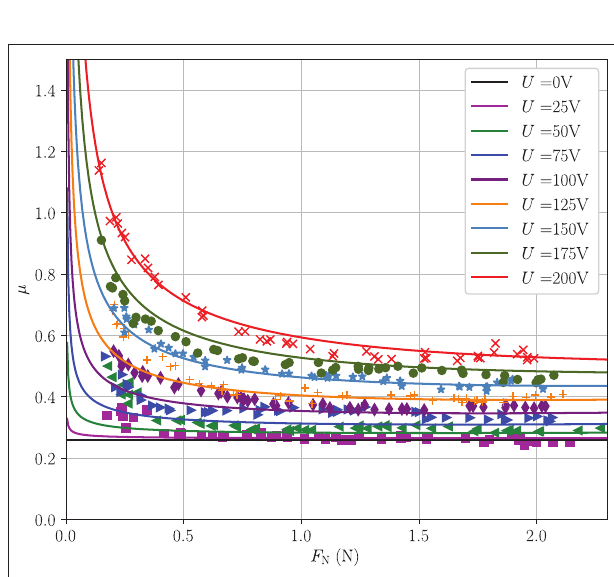
FIGURE 10 | Model predictions (lines) and experimental results (symbols) of Sirin et al. (2019a) of tangential force against normal force for voltages of 25–200 V.